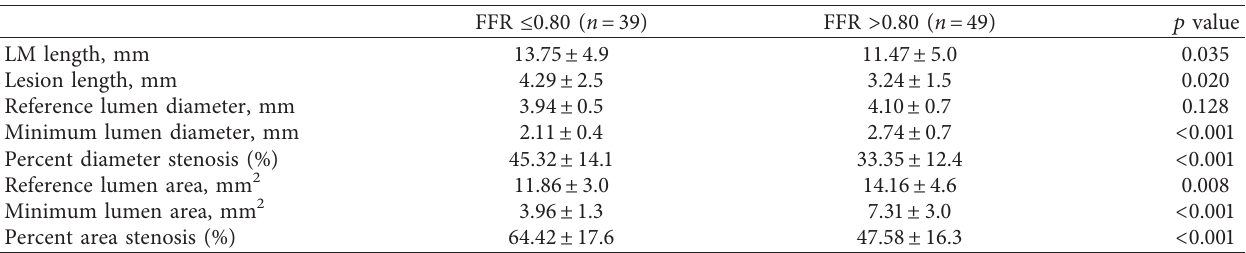
Table 3: Comparison between optical coherence tomography measurements of LM stenosis with FFR ≤ 0.80 and FFR >